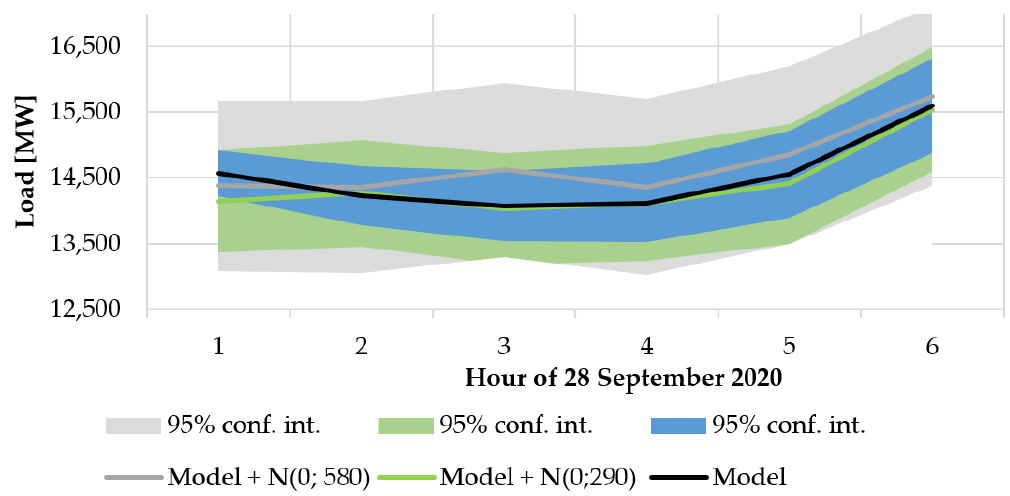
Figure 10. Model and disturbed time series forecasts with confidence interval.